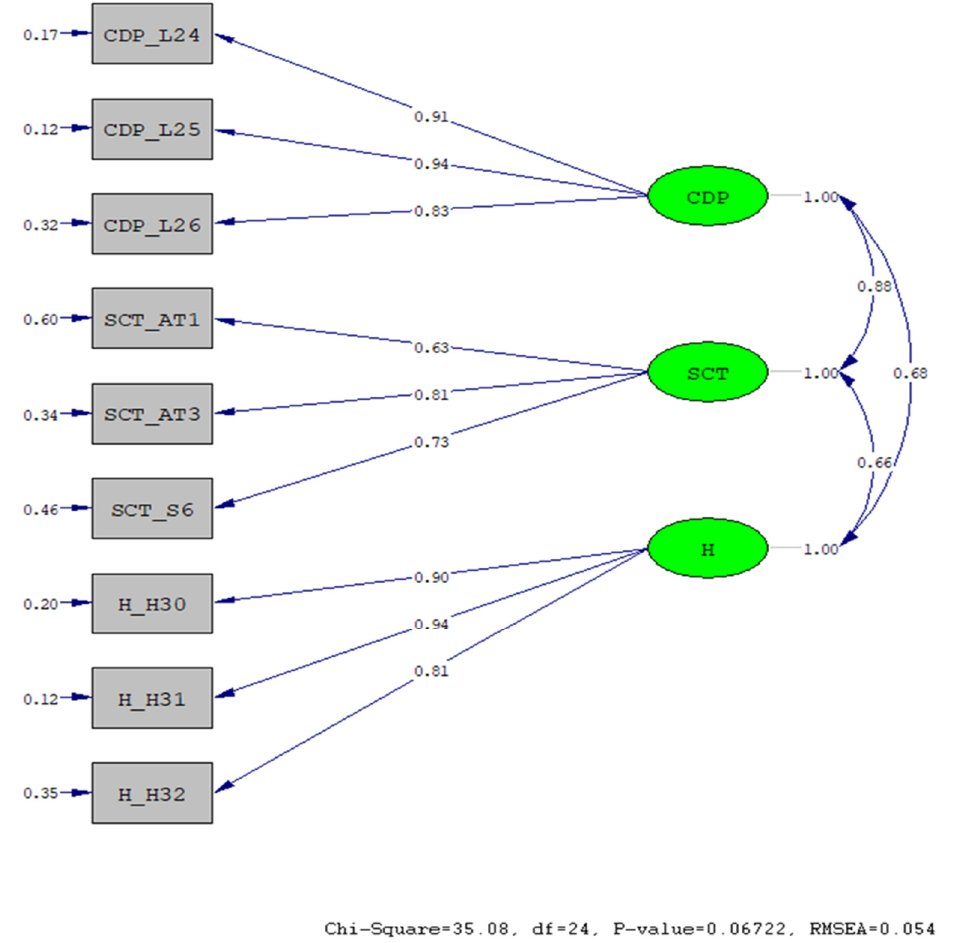
Figure 2. Diagram of the Final Model of the Scale of Causes of churning. Notes. CDP (PPC): Profes- sional Performance Conditions; SCT (SWC): Satisfaction with Working Conditions; H (S): Schedule. The goodness-of-fit of the model was within the recommended values (Table 7) and it was superior to the index of the initial solution. Table 7. Goodness-of-Fit Indicators of the Final Measurement Model regarding Causes of Churning.